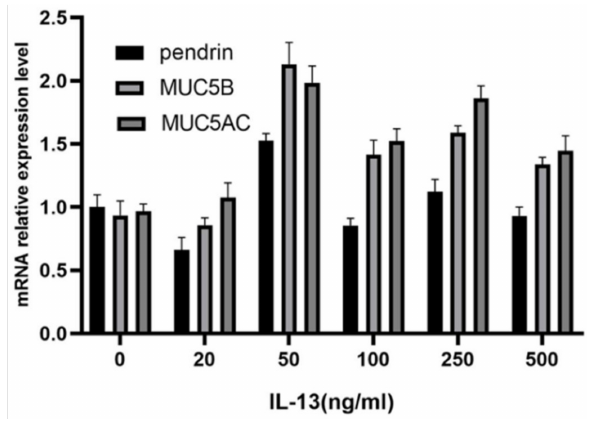
Figure 2. Interleukin-13 (IL-13) induces mucin 5AC (MUC5AC), MUC5B, and pendrin mRNA expression in primary human nasal epithelial cells (HNECs). The IL-13 concentrations applied were 0, 20, 50, 100, 250, and 500